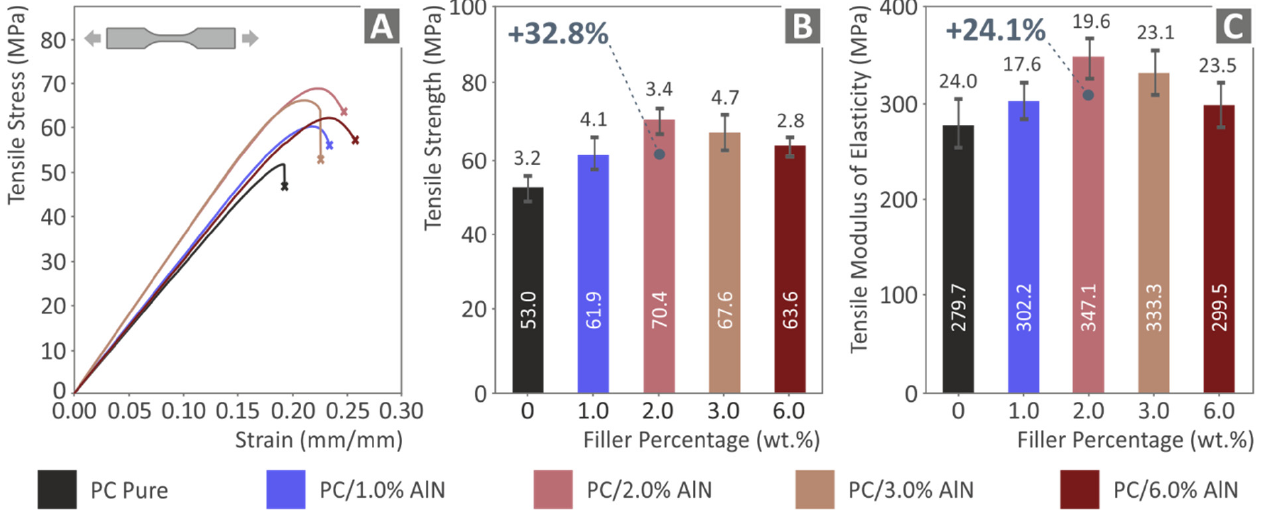
Figure 9. Tensile tests results of the 3D printed samples: ( A ) tensile stress graph as a function of strain, ( B ) tensile strength (average values and deviation), and ( C ) tensile modulus of elasticity (average values and deviation) of the five tested specimens.